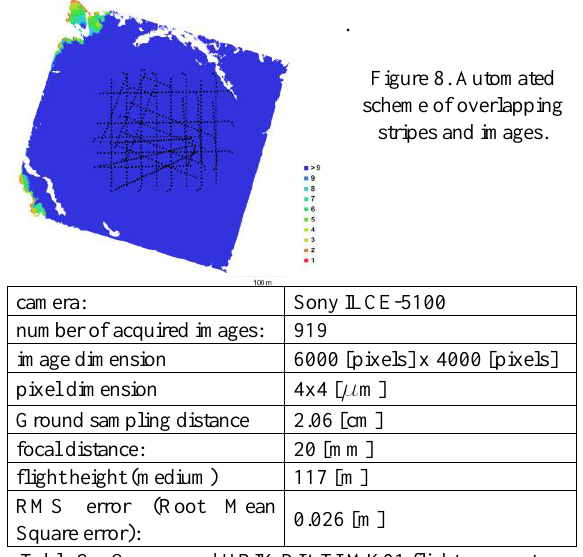
Table 2 – Camera and UBIK DIATI MK01 flight